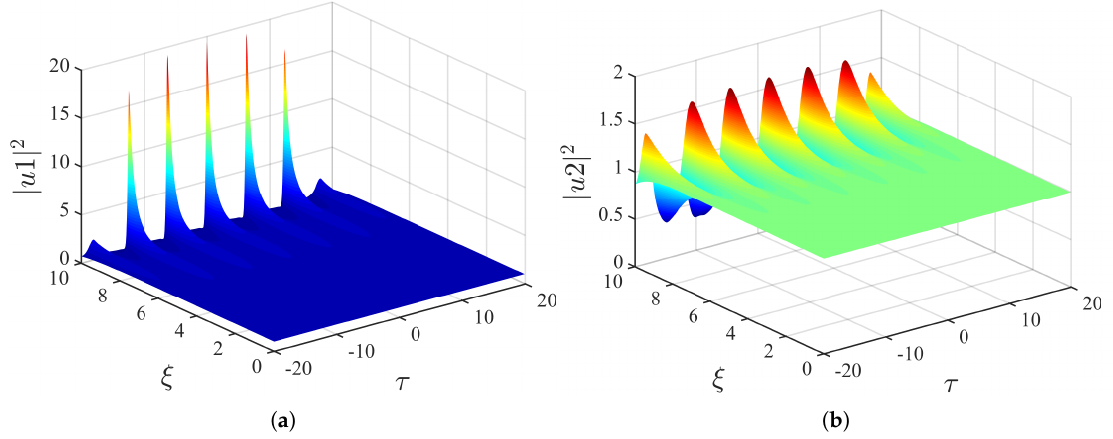
Figure 18. The same as in Figure 17, but when the difference in the GVD coefficients is α =